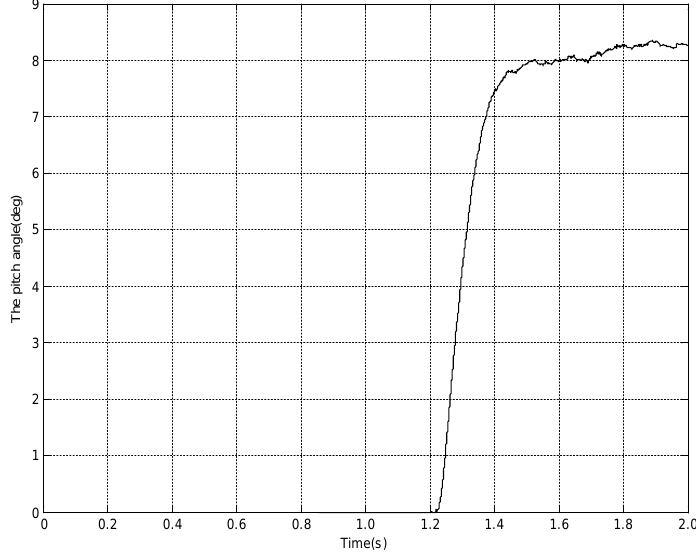
Figure 9. The simulation curve of the pitch angle.